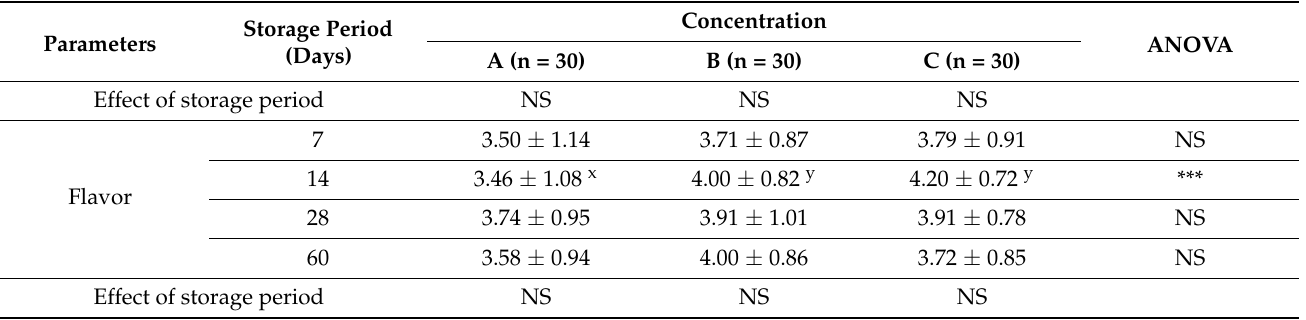
Table 3. Determination of safranal (µg/ 100 g ham; means ± s. e.) in sachets of sliced dry-cured ham during the storage period.